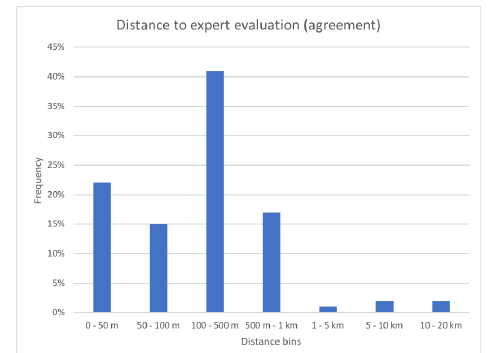
Figure 15. Accuracy achieved with Agreement aggregation